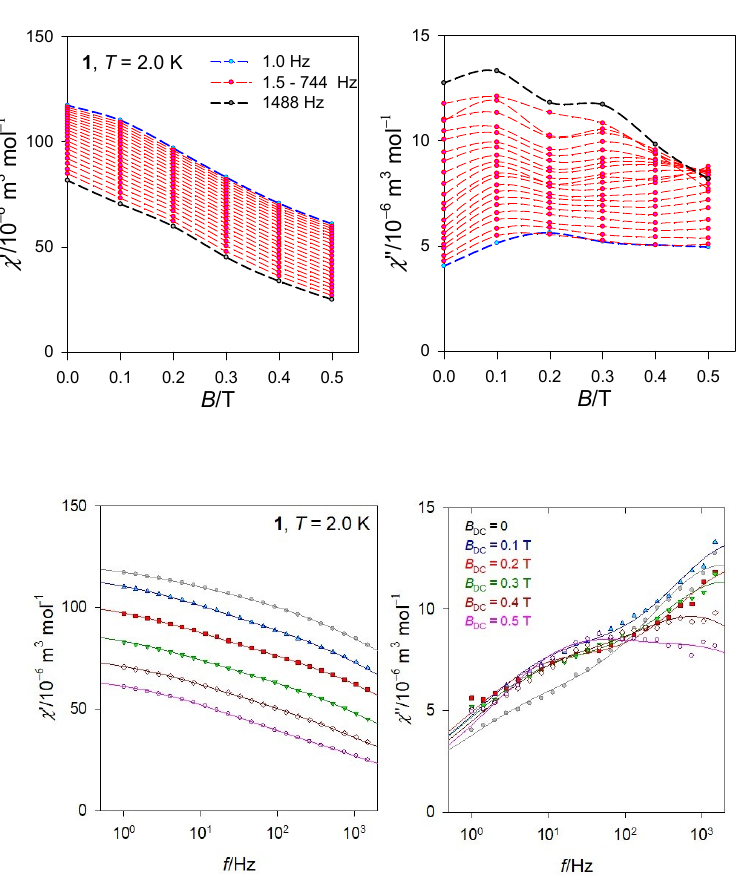
Figure 5. Field dependence ( top ) and frequency dependence ( bottom ) of the AC susceptibility components for 1 at T = 2.0 K. Dashed—guide for eyes; solid lines—fitted.